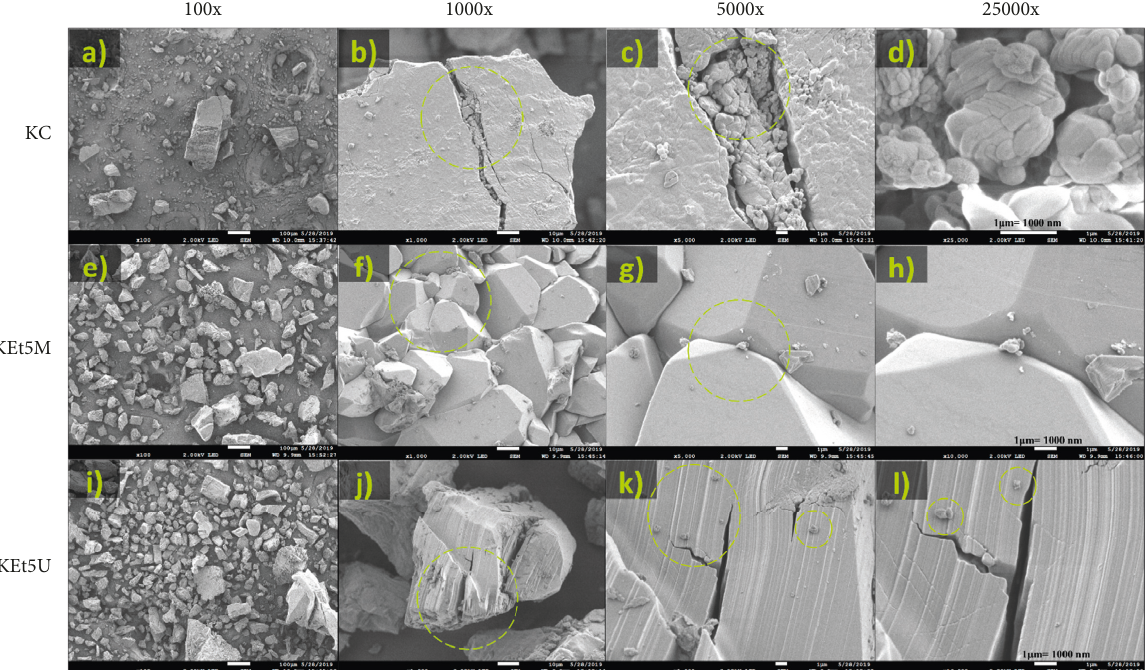
Figure 10: Scanning electron micrographs at different magnifications for the KC: (a) 100x, (b) 1000x, (c) 5000x, and (d) 25000x; KEt5M: (e) 100x, (f) 1000x, (g) 5000x, and (h) 25000x; KEt5U: (i) 100x, (j) 1000x, (k) 5000x, and (l) 25000x